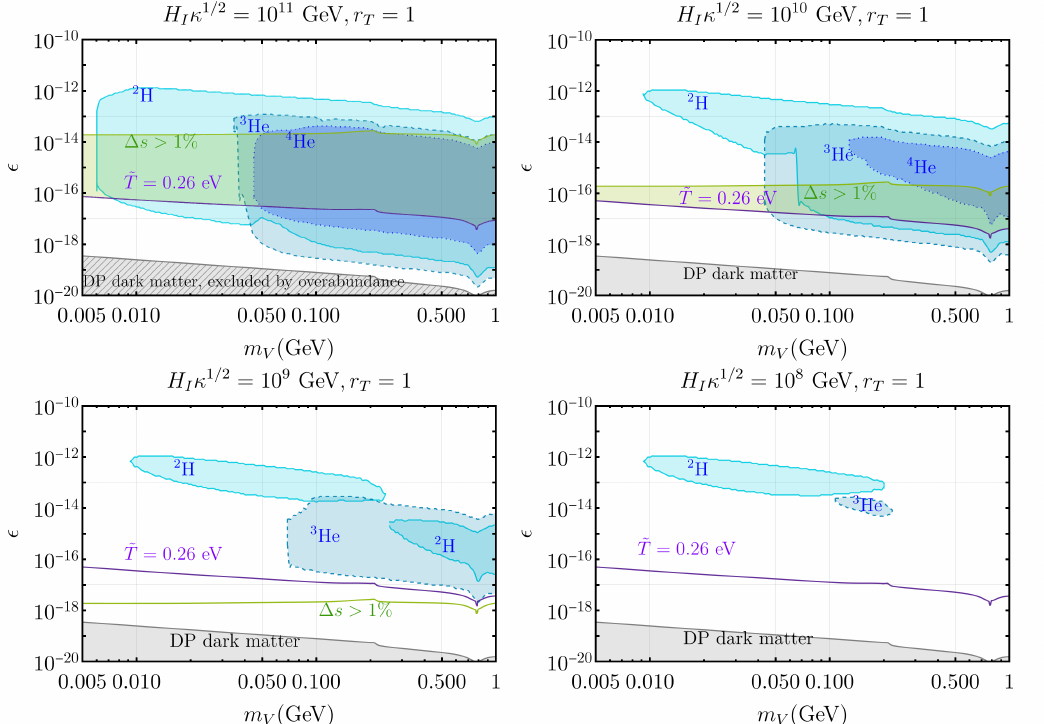
Figure 7 . The shaded regions delimited by solid, dashed, and dotted lines are ruled out at 95% CL due to the BBN photodisintegration effects from the measurement of primordial abundance of 2 H, 3 He, and 4 He, respectively. The green shaded area ( ∆ s > 1 %) denote the region where the entropy injection from the dark photon decay after the BBN but before the CMB (after the purple line ˜ T = 0 . 26 eV) is larger than 1%. In the shaded area below the gray line (DP dark matter), the dark photon has a lifetime longer than the age of the Universe and is a dark